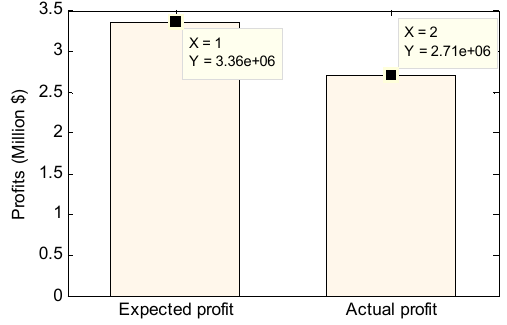
Figure 14. Expected and actual profits for the case of operating the energy storage unit.